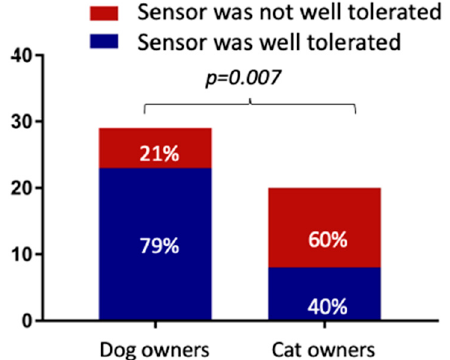
Figure 3. Comparison of dog and cat owners’ points of view regarding problems related to premature sensor detachment.